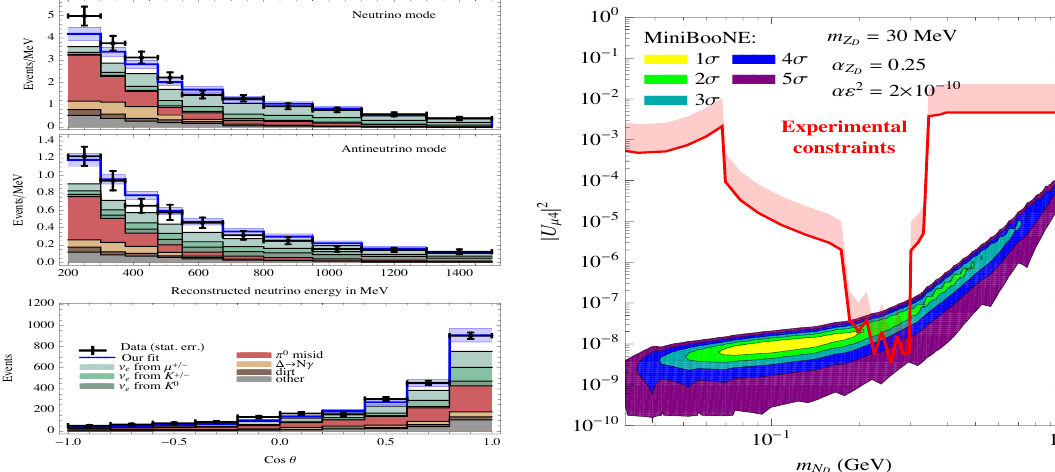
Figure 8.2: Left: The MiniBooNE electron-like event data [ 175 ] in the neutrino (top panel) and antineutrino (middle panel) modes as a function of E rec , as well as the ν cos θ distribution (bottom panel) for the neutrino data. Note that the data points have only statistical uncertainties, while the systematic uncertainties from the back- ground are encoded in the light blue band.. The predictions of our benchmark point = 420 MeV, m = 30 MeV, | U | 2 = 9 × 10 − 7 , α = 0.25 and α(cid:34) 2 = 2 × 10 − 10 m µ 4 N Z D | 2 versus m D D are also shown as the blue lines. Right: Region of our model in the | U µ N 4 = 30 MeV, D plane satisfying MiniBooNE data at 1 σ to 5 σ CL, for the hypothesis m Z α = 0.25 and α(cid:34) 2 = 2 × 10 − 10 . The region above the red curve is excluded at D Z D 99% CL by meson decays, the muon decay Michel spectrum and lepton universal- ity [ 112,176 ]